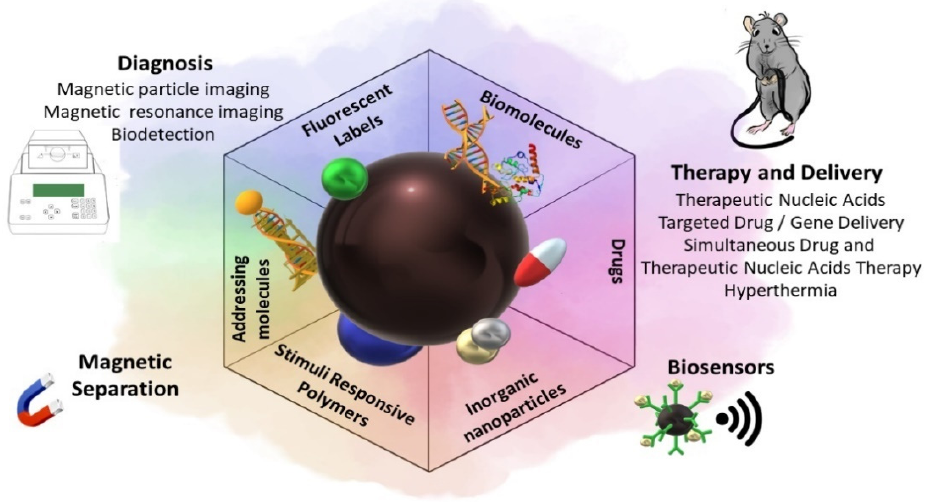
Figure 8. Diagnostics, therapy, drug and gene delivery, biosensor, and magnetic separation appli- cations of